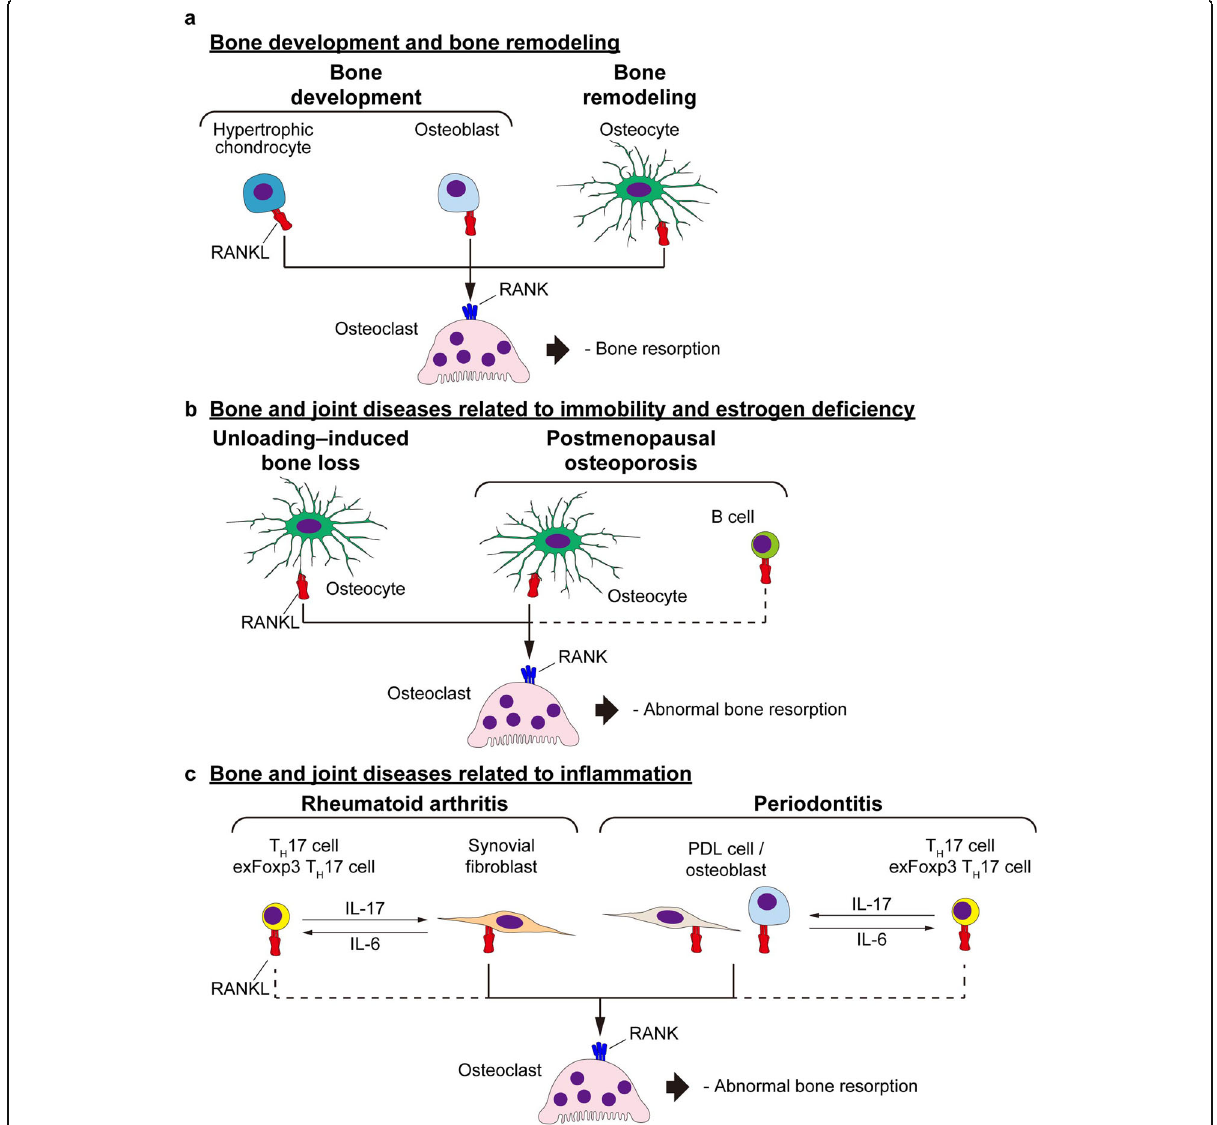
Fig. 1 RANKL in bone metabolism. a The RANKL – RANK interaction in bone development and remodeling. Hypertrophic chondrocytes and osteoblasts function as the source of RANKL during growth. After the growth period, osteocytes are the major source of RANKL. RANKL induces the differentiation of osteoclasts, which resorb bone matrix. b RANKL – RANK interaction in bone and joint diseases related to immobility and aging. The bone loss induced by unloading is induced by osteocyte RANKL. B cell RANKL is reported to partially contribute to the bone loss in postmenopausal osteoporosis, as well. c In the lesion that occur in rheumatoid arthritis, synovial fibroblasts stimulated with pro-inflammatory cytokines, including IL-17, express RANKL and enhance osteoclastogenesis. In periodontitis, RANKL is mainly provided by PDL cells and osteoblasts. (see also Table 2). The IL-17 in these processes is produced by T H 17 cells stimulated by IL-6. T H 17 cells (exFoxp3 T H 17 cells, in particular) express RANKL as well. RANKL receptor activator of NF- κ B ligand, RANK receptor activator of NF- κ B, T H 17 cell T helper 17 cell,